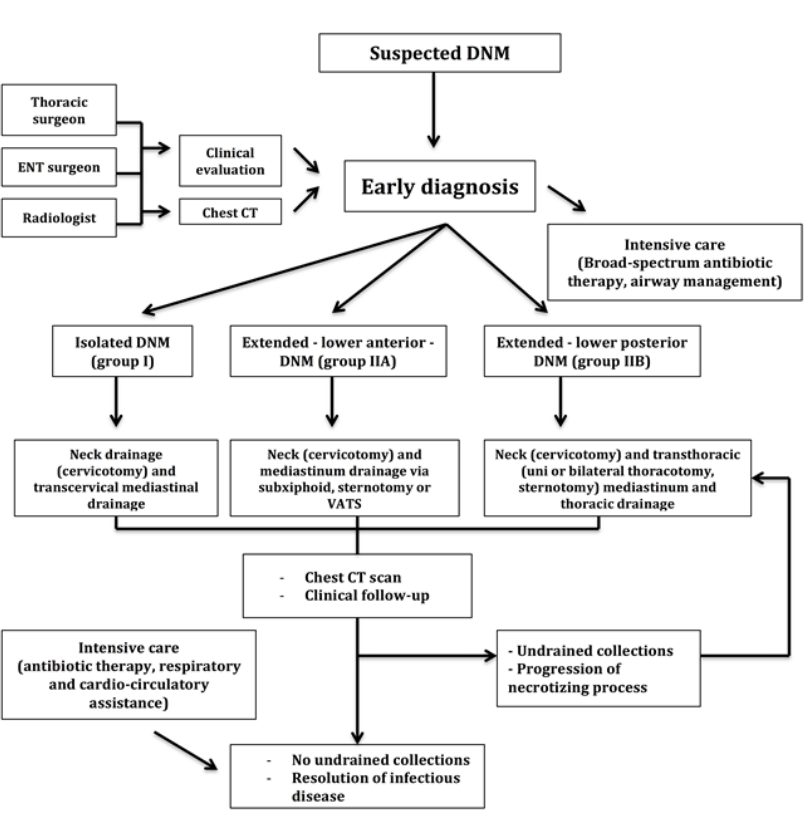
Figure 1: Algorithm of